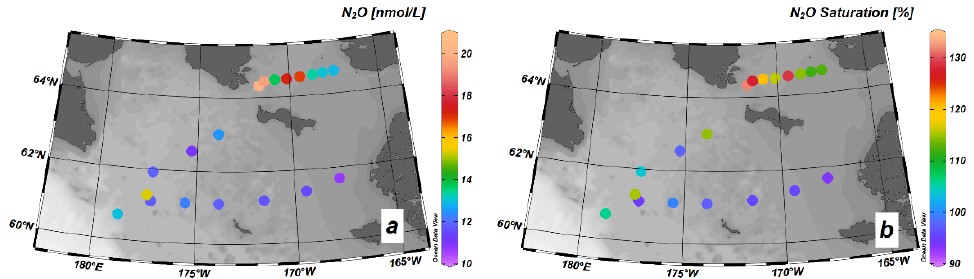
Figure 3. Distributions of N 2 O concentration ( a ) and saturation ( b ) in the surface water of the northeastern Bering Sea shelf in summer 2012.